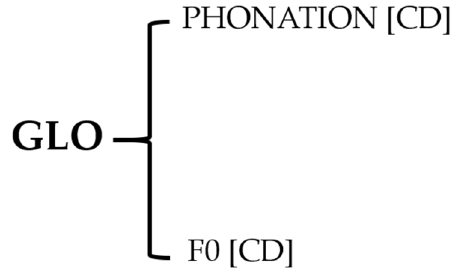
Figure 13. The GLO tier, subdivided into the PHON(ATION) tier and the F0 tier.